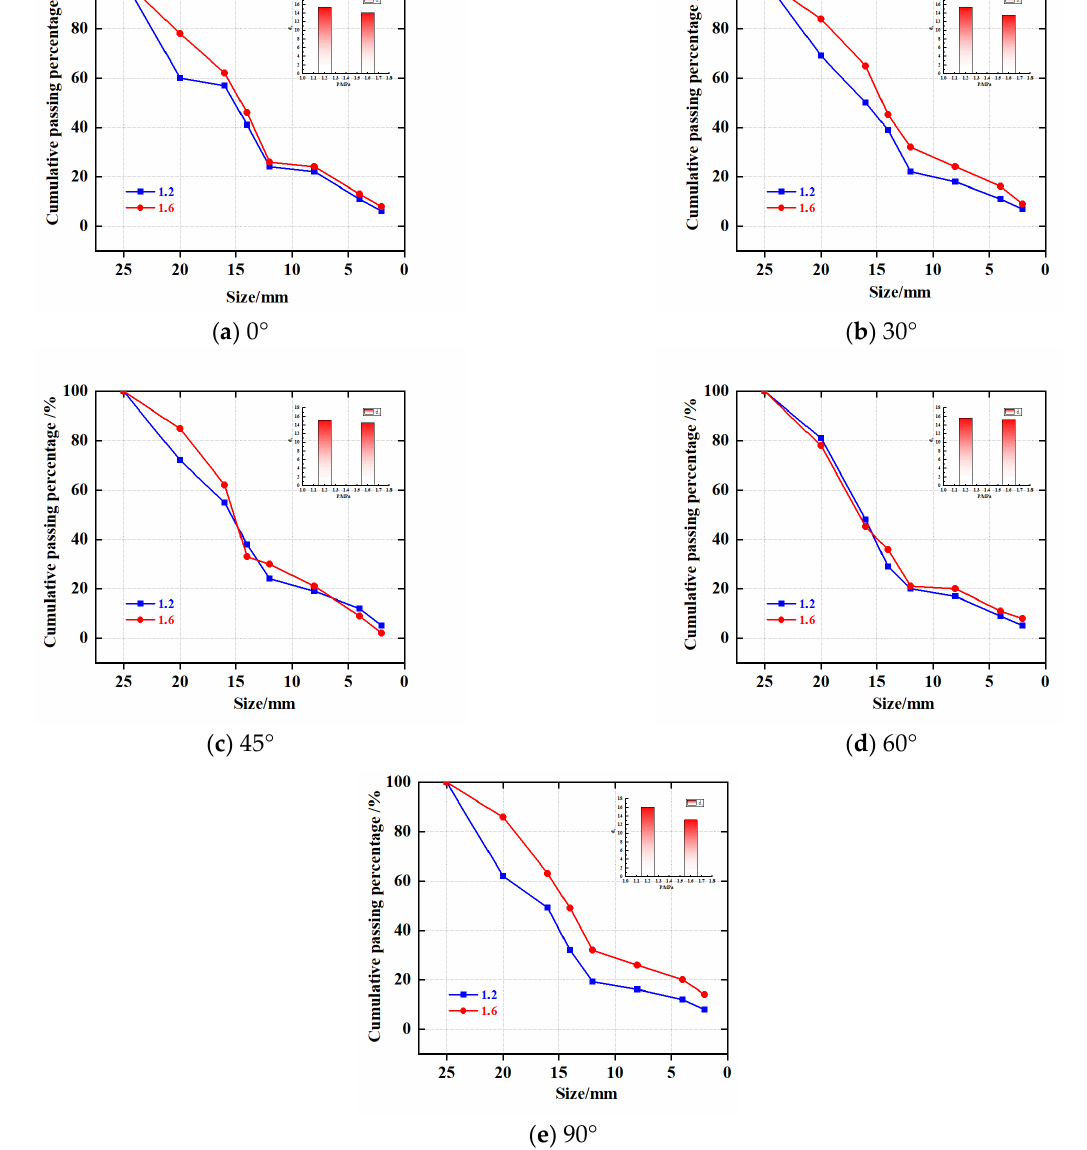
Figure 12. Particle size distribution curve.